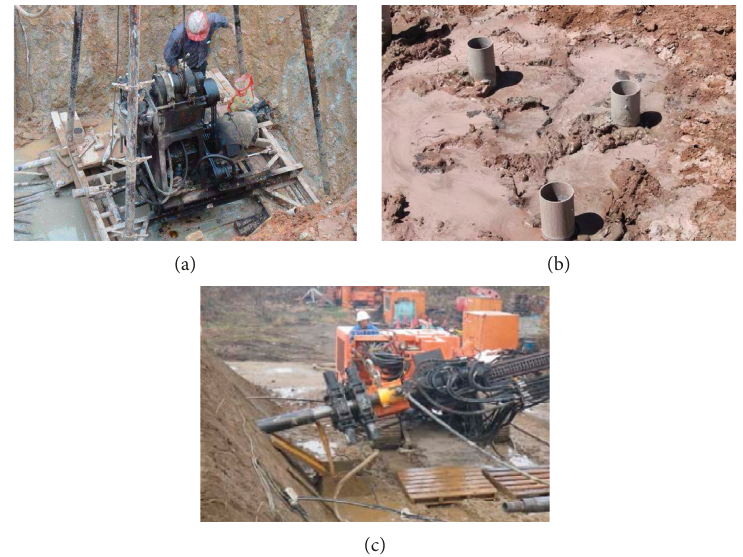
Figure 11: Solidification of the saline soil in the subgrade.